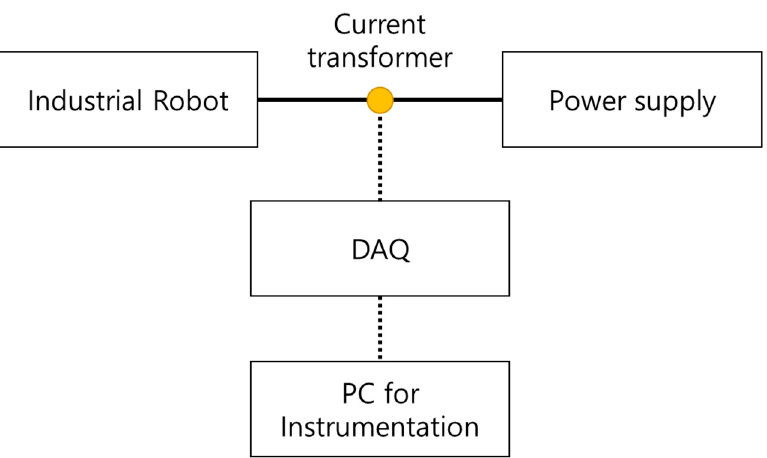
Figure 8. Description of the data acquisition system ( a ) 6-axis, vertically articulated robot; ( b ) current transformer; ( c ) DAQ module; ( d ) PC.